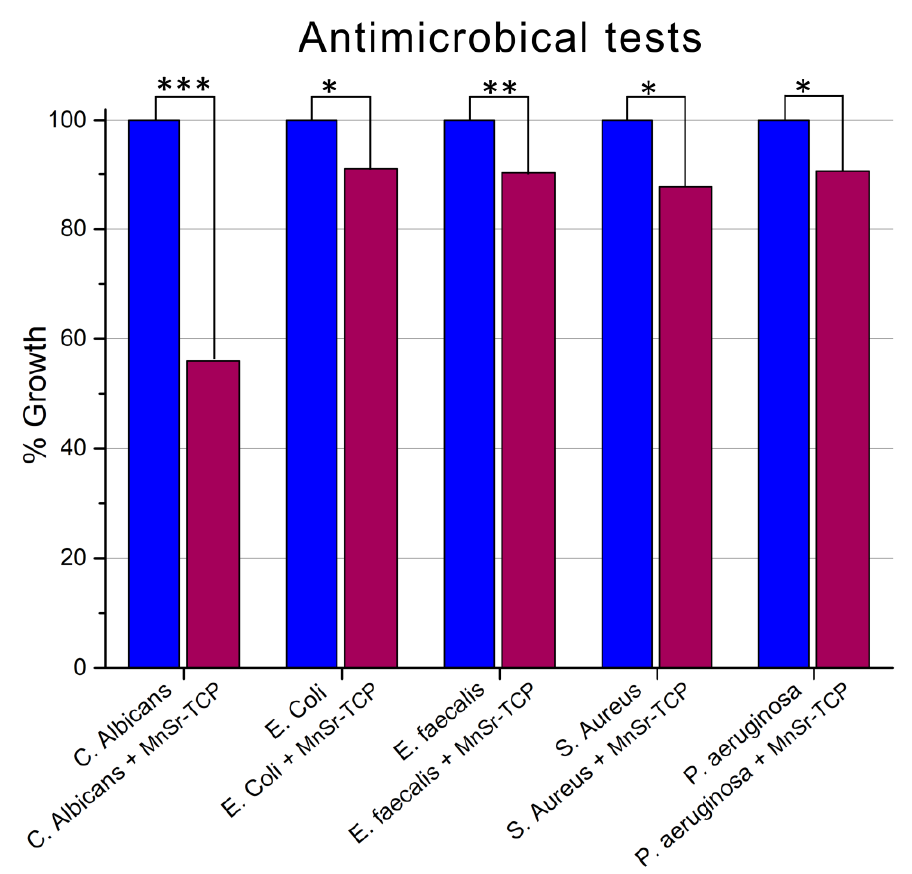
Figure 8. Growth rate of four bacteria ( S. aureus , E. coli , S. typhimurium , and E. faecalis ) and one fungus ( C. albicans ) grown in the presence and absence of Mn,Sr-TCP Zn-Li samples. The percentage of growth is calculated from three independent experiments. Statistical significance is reported for each bacterial group: *** ( p < 0.001), ** ( p < 0.01), * ( p < 0.05).